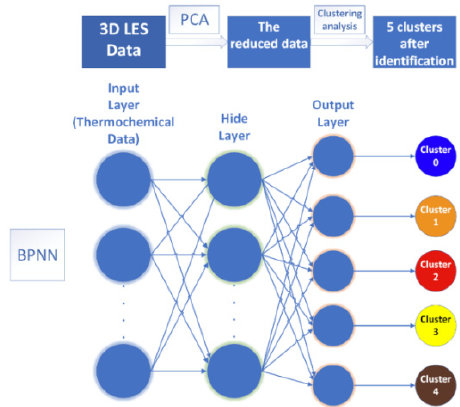
Figure 3. Process of identifying methods and the network structure.